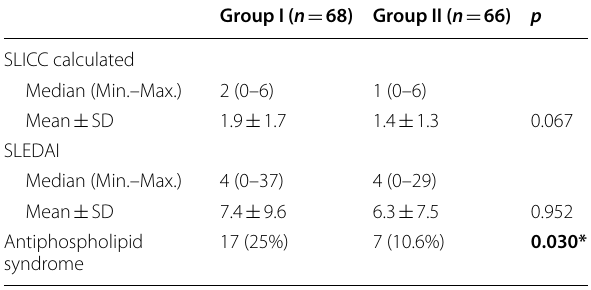
Table 4 Comparison between the studied groups according